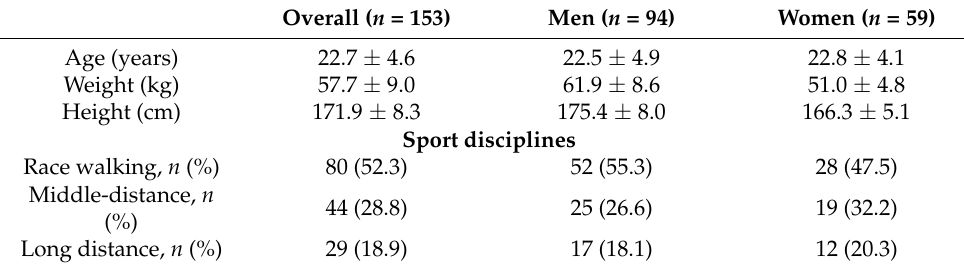
Table 2. Age, height, weight, and sex of athletes according to athletes in different sport disciplines.